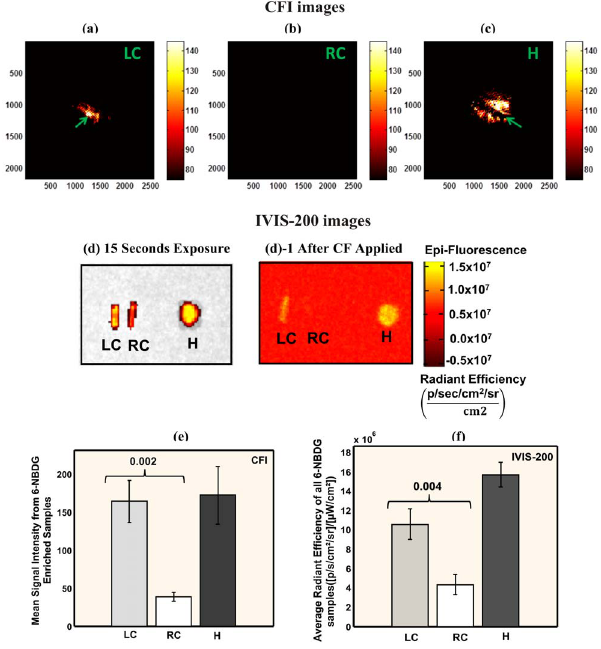
Figure 5. Fluorescence imaging of ex vivo murine carotids arteries. Fluorescence imaging was taken one hour after 6-NBDG intravenous injection (177 m L) with the CFI imaging system: (a–c) and with the IVIS-200 imaging system: (d, d-1). (a) LC: ligated left carotid artery with white area (green arrow) in the middle representing the ligation location, (b) RC: non-ligated right carotid artery artery (negative control), (c) H: heart (positive control). Dark line in the heart represents a gap in signal due the ventricular cavity (green arrow). (d) IVIS-200 images with GFP and GFP-background filters at 15 seconds exposure. (d)-1 processed image of (d) after a CF applied and background noise subtracted. (e) Average signal intensity of all samples (n=3) was calculated based on the CFI system images. (f) Average radiant efficiency from the same samples is shown based on the IVIS-200 system images. High fluorescence signal from LCs was detected by the CFI system and confirmed by IVIS-200.